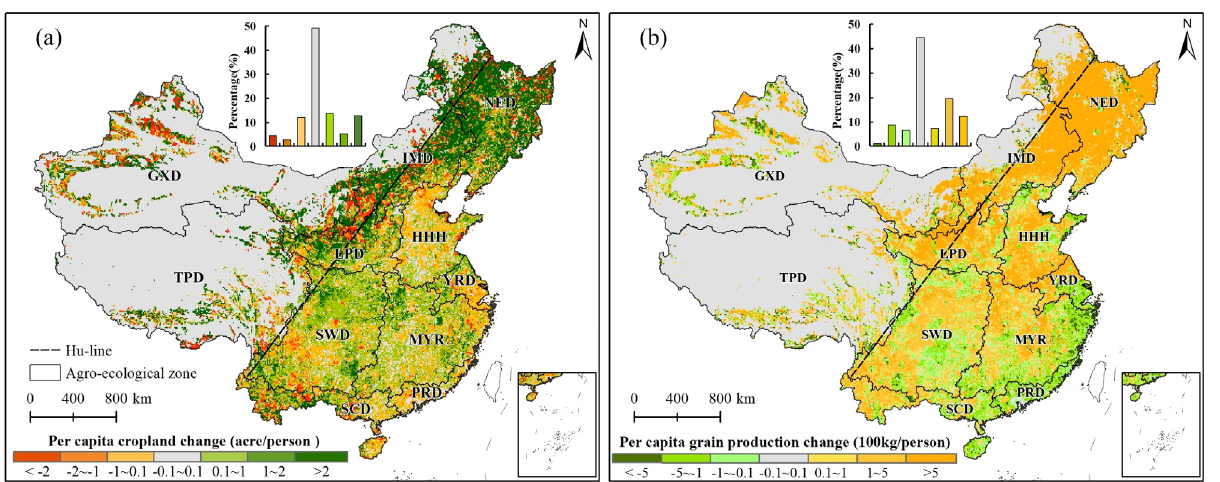
Figure A1. Spatial pattern of changes in per capita cropland area ( a ) and per capita grain possesion ( b ) in China over the past two decades.